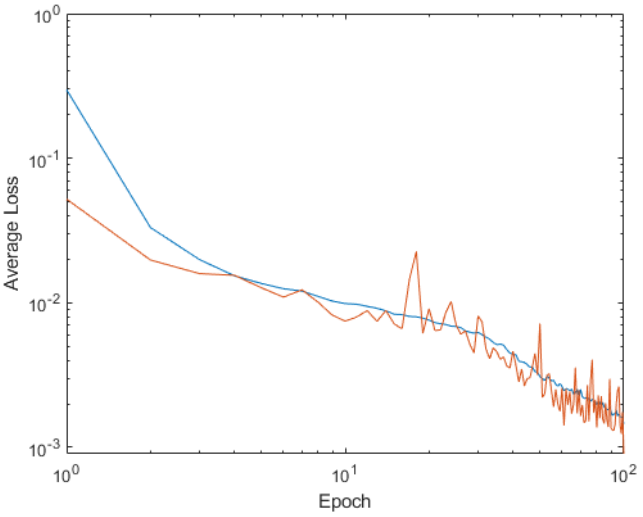
Figure 30. Average loss on training patterns in blue and validation patterns in orange for Standard SGD of Goldstein Prize function.